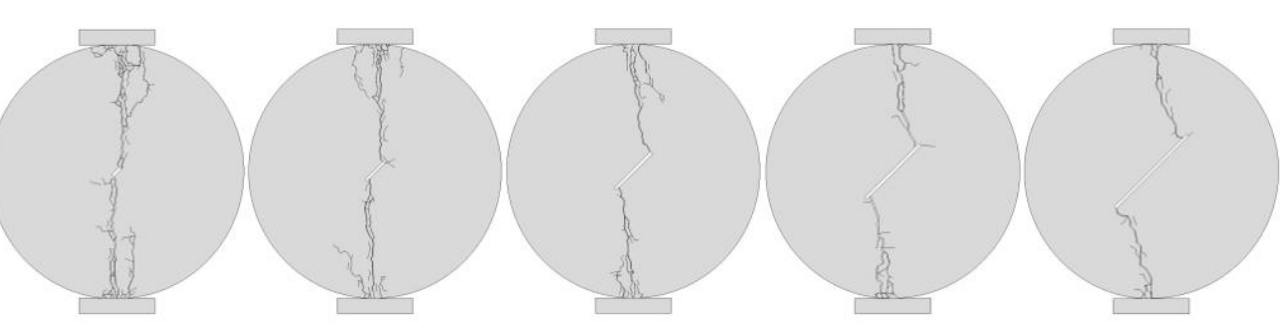
Figure 27. The failure mode for Brazilian discs with 0° cracks of different length. The crack lengths are 2 mm, 5 mm, 10 mm, 15 mm and 20 mm, respectively.